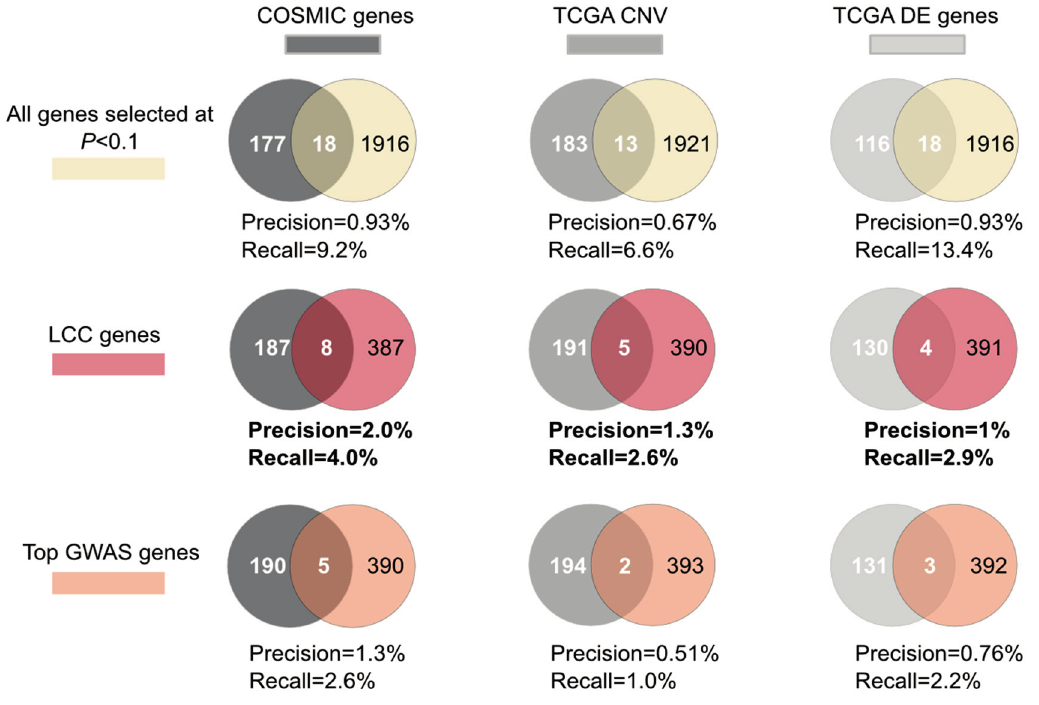
Figure 3. LCC performs better than GWAS top genes in retrieving known breast cancer genes. Venn diagrams showing the overlap between genes reported to be differentially expressed (retrieved from the TCGA data portal, using the default parameters ( − 0.5 < Log2 < 0.5; frequency = 40%) or to harbor copy number abnormalities (retrieved from the TCGA data portal, using the default parameters − 0.5 < Log2 < 0.5; frequency = 20%) or somatic mutation (genes with at least five cases reported in COSMIC database) in breast cancer, with each of the sets of genes selected from the breast cancer GWAS dataset by the previous gene selection approaches (all genes selected at a gene-wise p -value <0.1, LCC genes and top GWAS genes, represented in light yellow, red and orange circles,